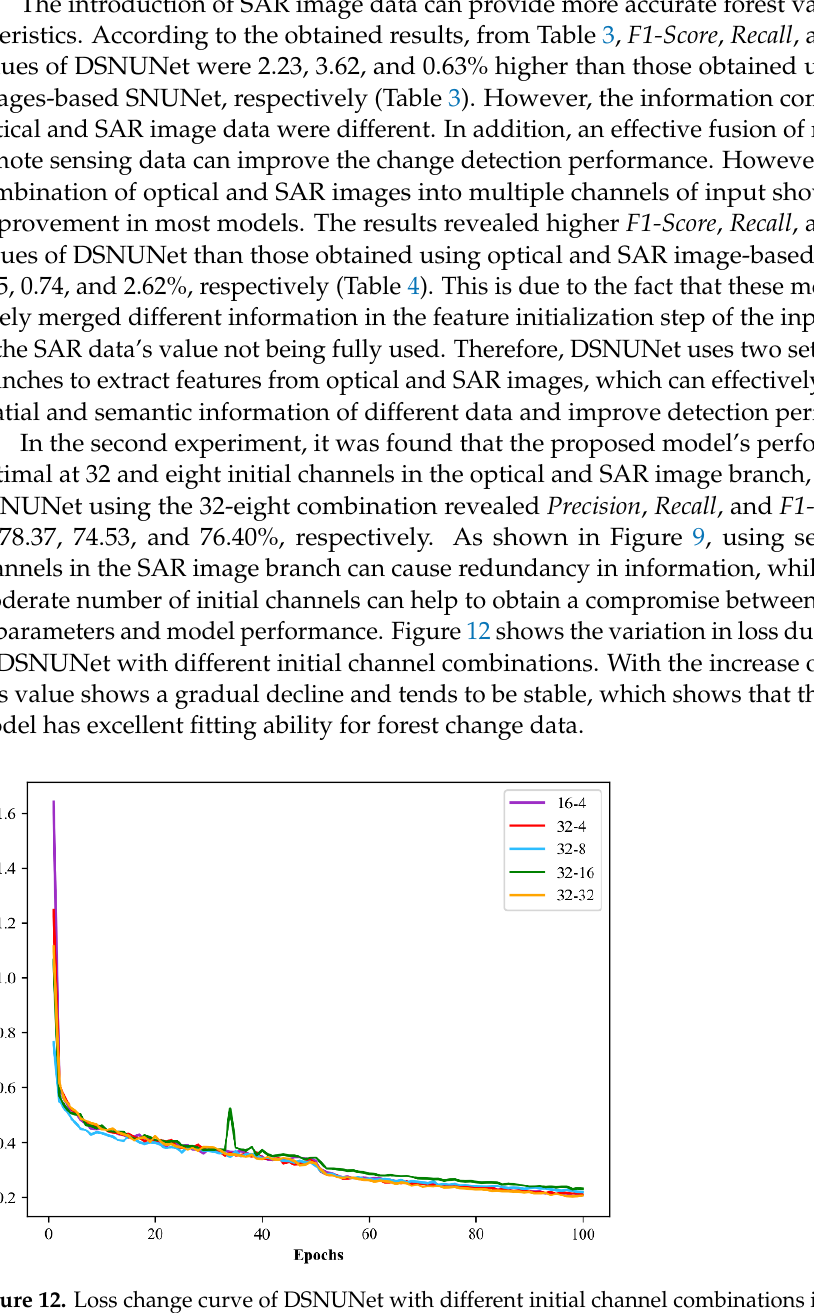
Figure 12. Loss change curve of DSNUNet with different initial channel combinations in the training step.